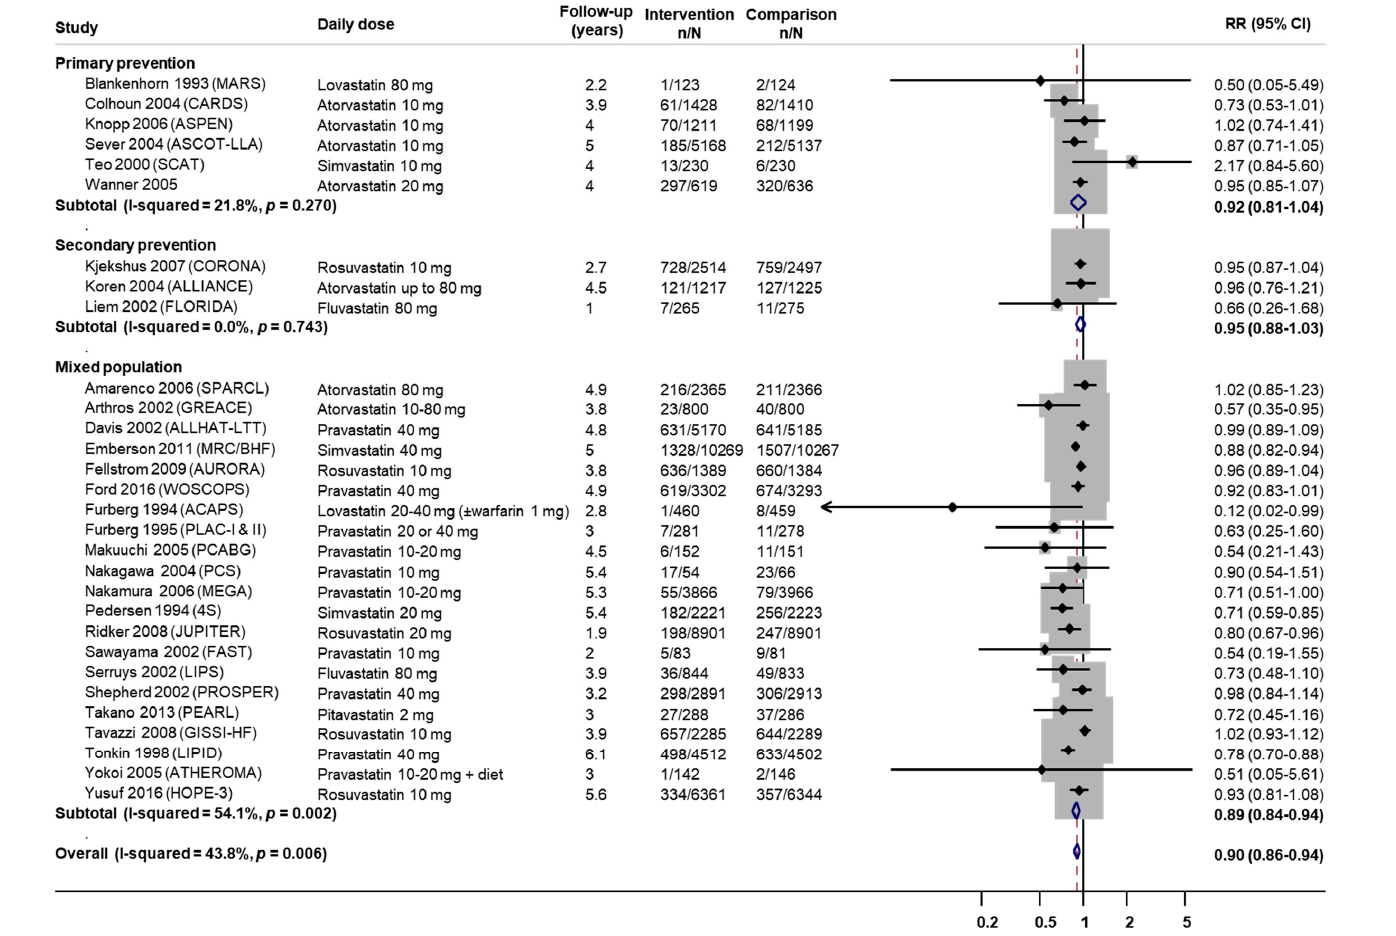
Figure A1. Subgroup meta-analysis for the effect of statin use on primary or secondary prevention of all-cause mortality. Full black quadrilateral represents the point estimate of individual studies and blank with quadrilateral represents pooled estimates. RR, relative risk; CI, confidence interval. Pooled estimates for the overall study population and subgroups are highlighted with bold